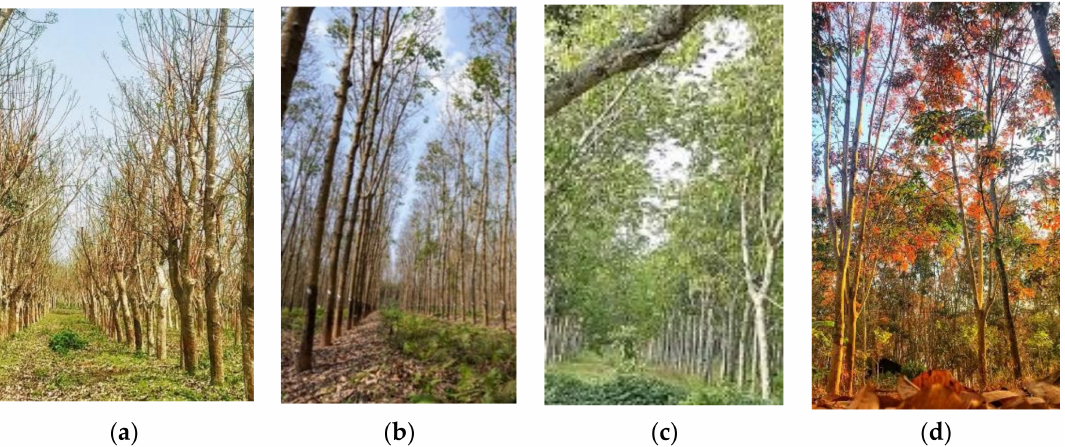
Figure 2. Photos of rubber plantations at different phenological stages. ( a ) Resting phase. ( b ) Recovery growth phase. ( c ) Vigorous growth phase. ( d ) Slowdown growth